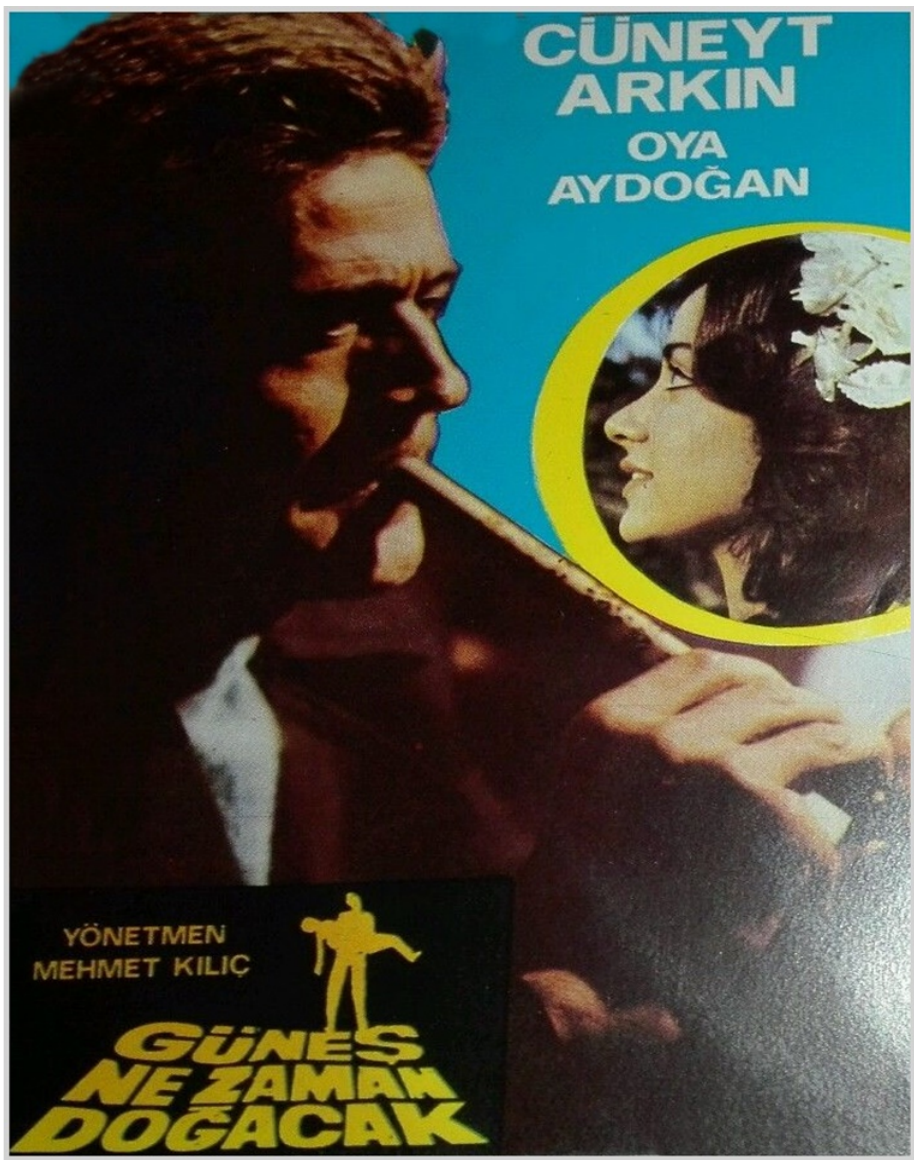
Figure 1- Cüneyt Arkın and Oya Aydoğan starring in “Güneş Ne Zaman Doğacak?”